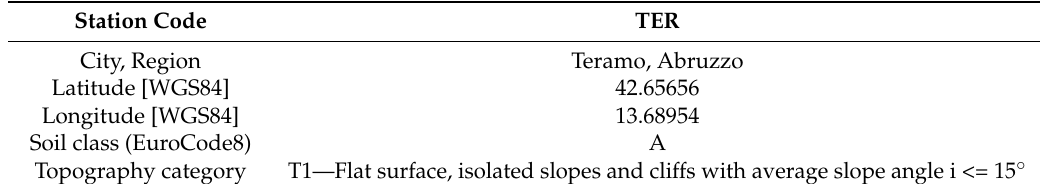
Details of the Terelle Accelerometric Station from the ITACA Database (the INGV accelerometric archive